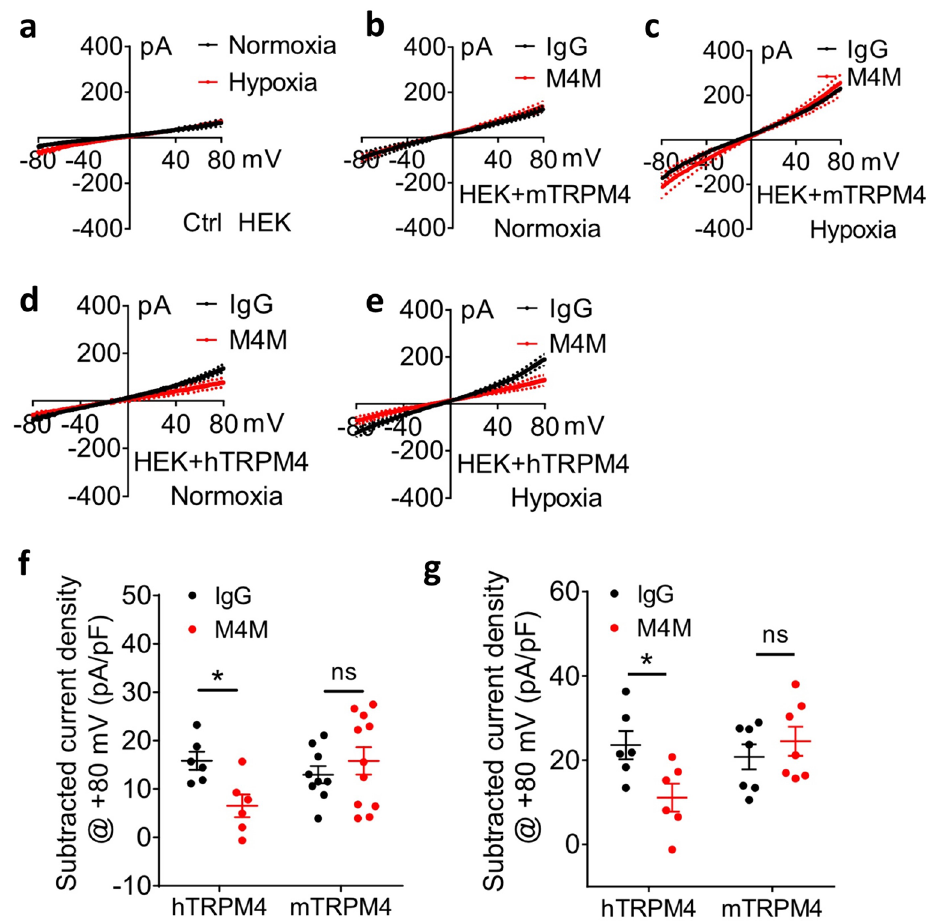
from − 80 to + 80 mV with a holding potential at 0 mV. n = 8 cells. ( b ) The current voltage relationships from HEK293 cells transfected with mouse TRPM4 under normoxia. The cells were pretreated with control